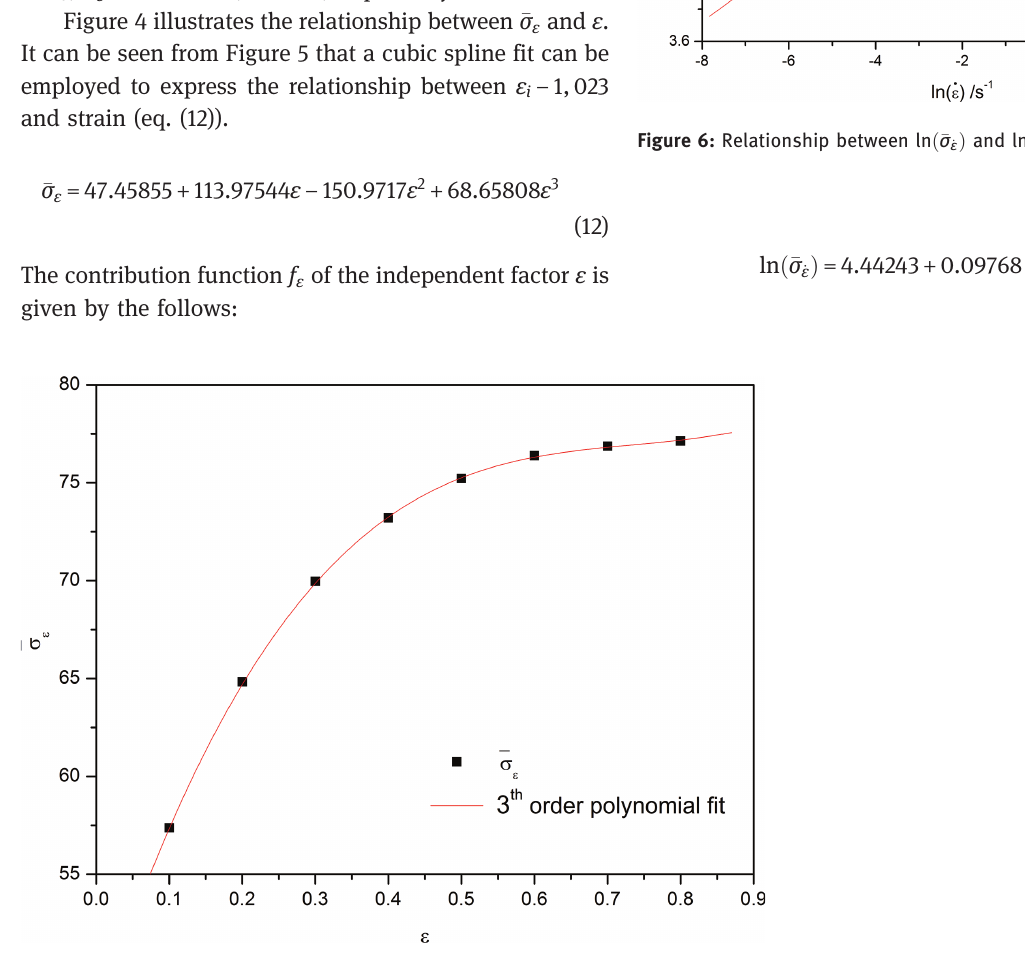
Figure 5: Relationship between (cid:2) σ ε and ε .